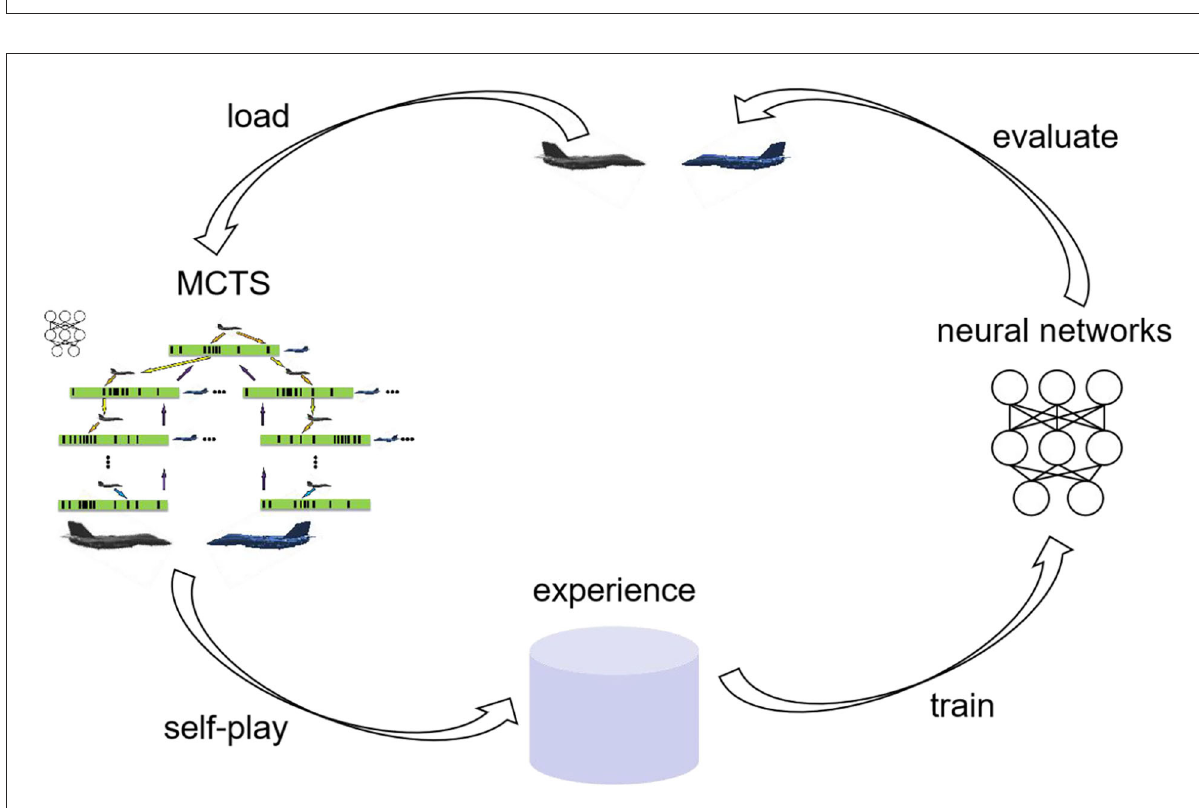
FIGURE5 Training agent.